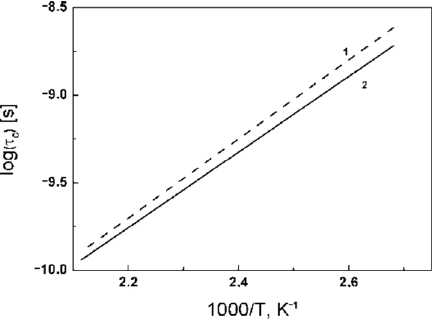
Figure 45. Temperature dependences of the correlation times τ c of 31 P nuclei: (1) composite material Cs 2 (HSO 4 )(H 2 PO 4 )-CsH 2 PO 4 = 2:1 and (2) α -Cs 3 (HSO 4 ) 2 (H 2 PO 4 )-Cs 2 (HSO 4 )(H 2 PO 4 ) = 1:1. Reprinted with permission Ref. [89]. Copyright © 2022 Springer-Verlag Wien.